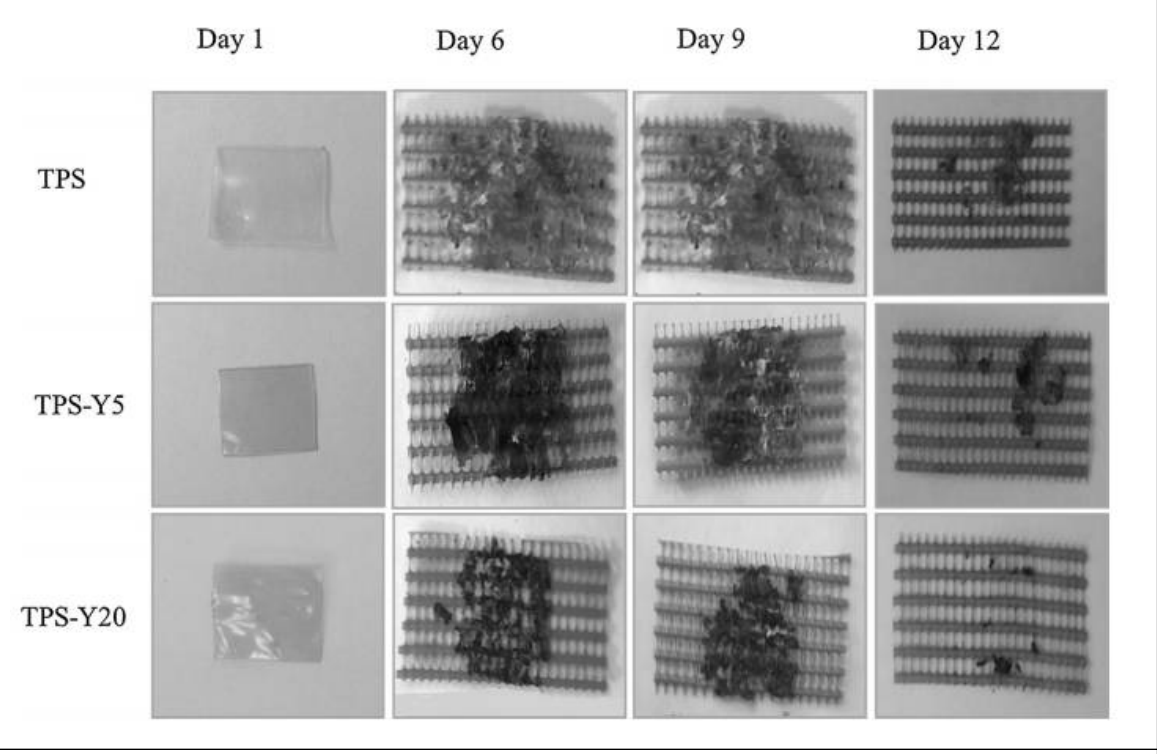
Figure 10: Biodegradation study of cassava-starch containing yerba mate extract in vegetal compost. Retrieved from (Medina et al,